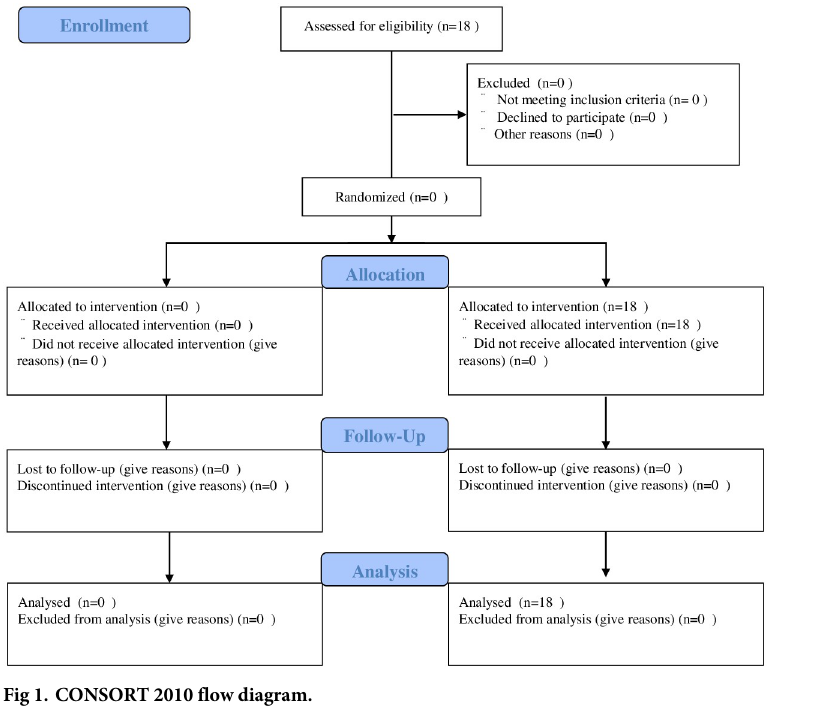
Fig 1. CONSORT 2010 flow